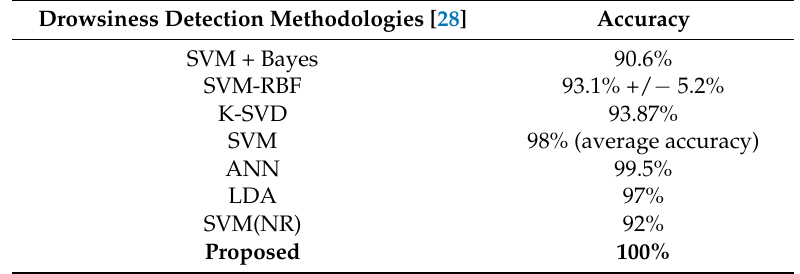
Table 1. Accuracy comparison with respect to such several methods reported in the review paper [28].